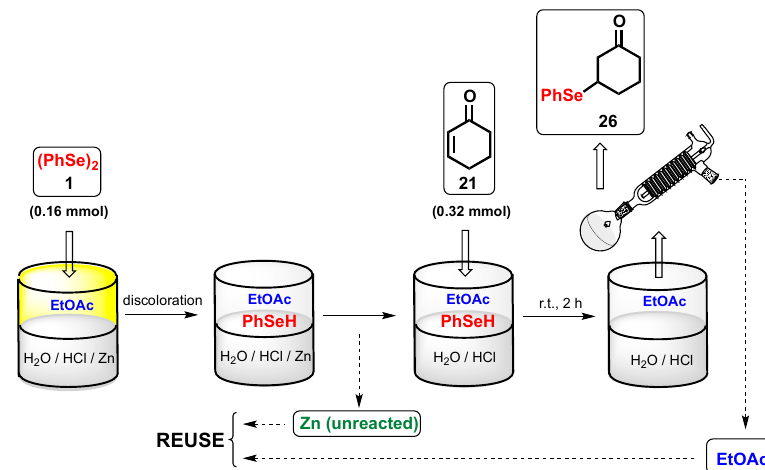
Scheme 3. Reuse of the aqueous phase in the Se-conjugate addition of diphenyl diselenide 1 to cyclohexenone 21.